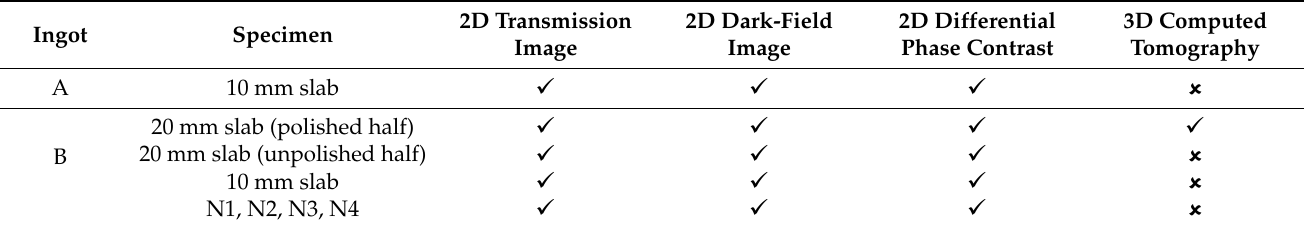
Table 2. Experiments conducted on each specimen.